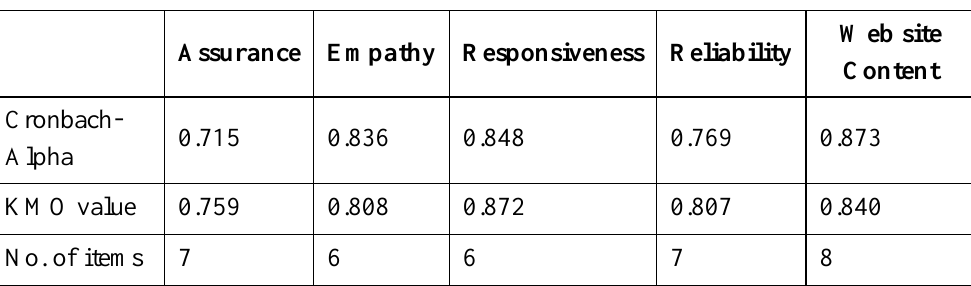
Table 01: Reliability and Validly